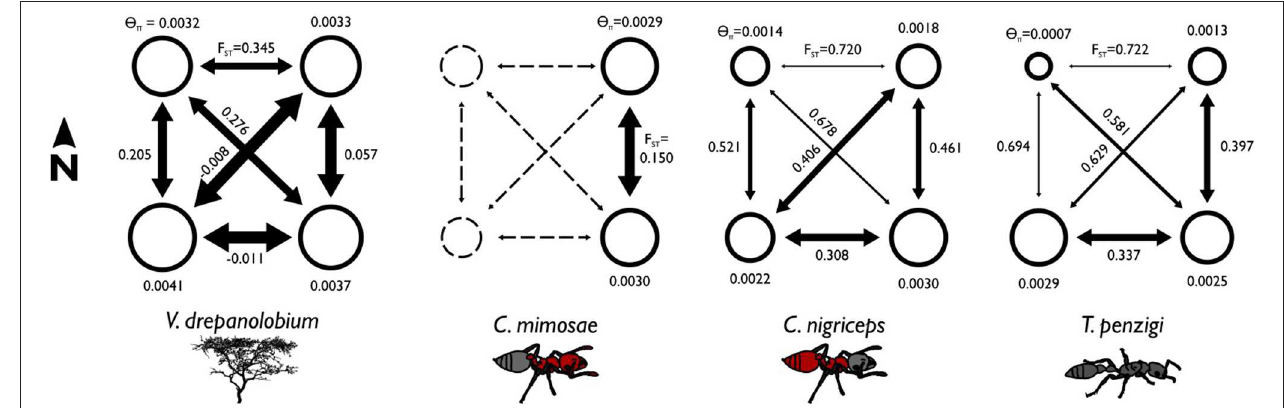
FIGURE 4 | Summary statistics show differences in the population structure of the different species. The area of each circle is proportional to the θ π value for each population, where θ π is a measure of genetic diversity within populations that scales with effective population size. The arrows are scaled inversely to F ST : F ST values closer to zero indicate greater gene flow between populations. θ values are similar across species, but F ST values are lower for V. drepanolobium and C. mimosae , showing high gene flow. F ST corresponds to the proportion of total genetic variation seen in the two populations that is partitioned between them. Negative values result from how F ST values are averaged across multiple loci; they may be read as effectively zero.